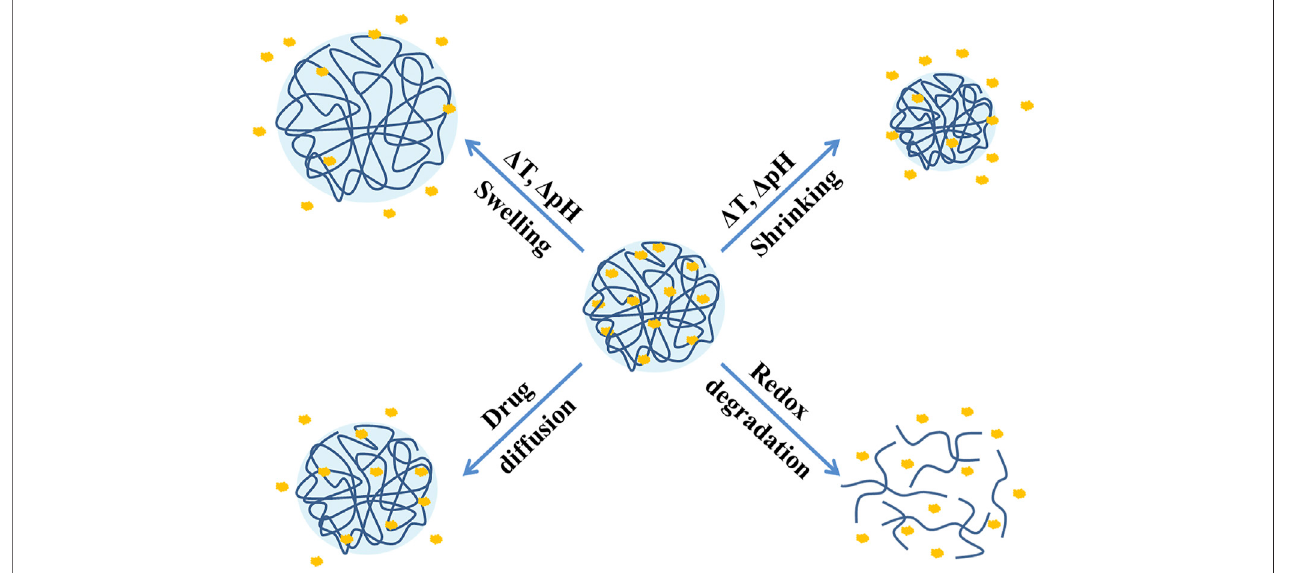
FIGURE 6 | Stimuli-responsive drug release mechanisms of